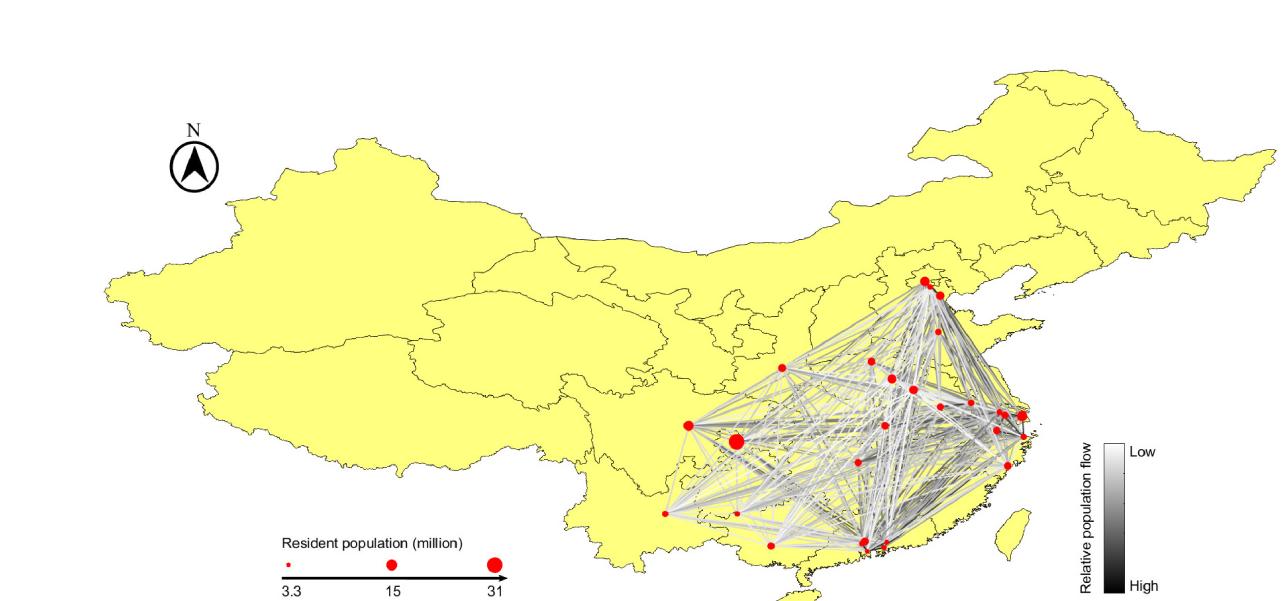
Fig 1. Mobility network among twenty-nine cities with the most active personnel movements in Mainland China in early 2020. A : The selected cities are ranked by the value of the migration rate from 1 to 22 January. B : The estimated relative outflow from Wuhan to other cities versus the observed aggregate population outflow. C : The mobility network among these cities. The diameter of nodes indicates the size of the resident population in each city, and the gray scale indicates the relative population flow between two cities. The base layer of the map was created using public sources: https://data.humdata.org/dataset/china-administrative-boundaries.